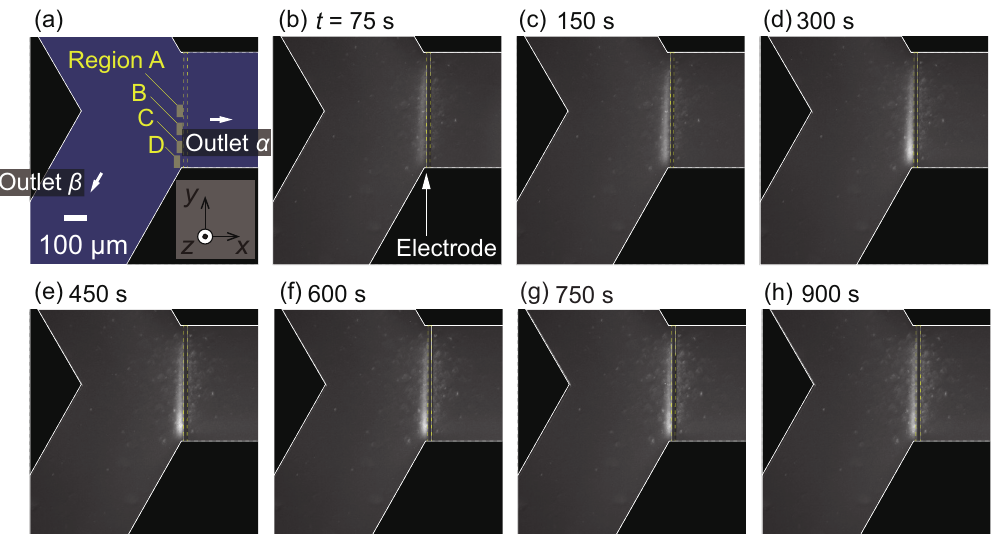
Figure 7. ( a ) Schematic figure of the test section and the positions of region A, B, C, and D analyzed in Figure 8; ( b – h ) Time series of the nanoparticle fluorescence. The particle flow separation is induced by microscale thermophoresis for the case with a particle diameter d = 100 nm and ∆ P = 0.5 Pa. At t = 0 s, the heating by electrode is initiated. Particle flow from the inlet is separated at the Y-shaped branch. Because the thermophoresis is directed to the colder region, the PS particles hardly enter the outlet α .